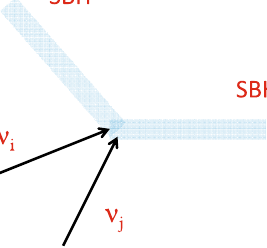
Fig. 1 Low 4-momentum sterile neutrino pair of global flavors ( i , j ) disappears into Schwarzschild BH (or the neutrino exchanges global charge with the SBH in a t-channel). This is described by a complex spurion field θ ij , and absence of an M 2 Tr (θ ∗